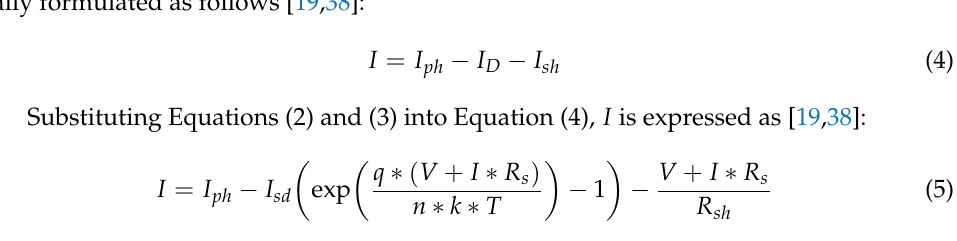
Figure 2. Equivalent circuit of the double diode model (DDM). 2.3. Photovoltaic (PV) Module The mathematical models of the SDM and DDM of a PV module that consists of a compound of (cid:1840) (cid:3046) cells connected in series can be also formulated as Equations (5) and (7), where (cid:1848) (cid:3047) = (cid:3015) (cid:3294) (cid:3038)(cid:3021) (cid:3044) [39]. 3. Artificial Jellyfish Search Optimizer Chou and Troung proposed a new MHA based on the behavior of jellyfish in the ocean—the artificial jellyfish search optimizer (JSO) [40]. The behavior of the JSO for searching for food in the ocean involves: following the ocean current or movements inside the swarm, and using a time control mechanism to switch between these movements. For the initialization steps, the authors in [40] observed several chaotic maps in addition to the typical random methods to find the better initialization way that will distribute the solutions within the search space of the problem accurately to accelerate the